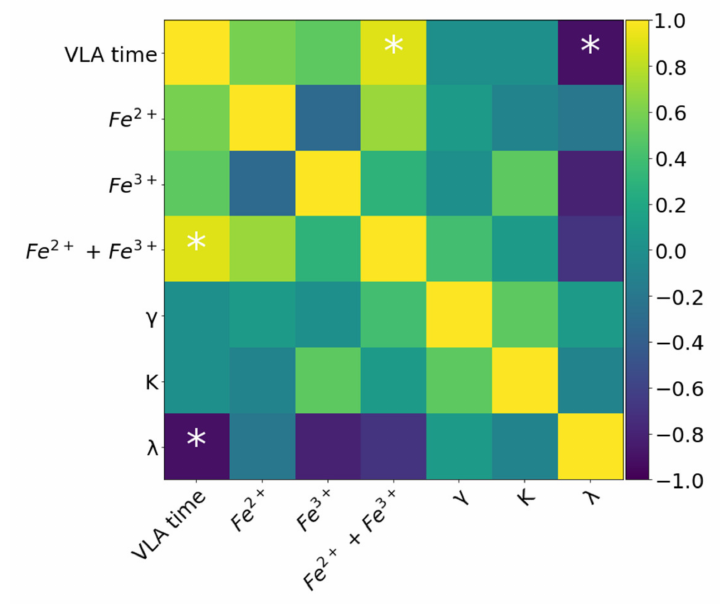
Figure 7. A heatmap of Spearman’s correlation coefficients between VLA time, dissolved forms of iron and kinetic parameters of H 2 production. *–Statistically significant values at p <